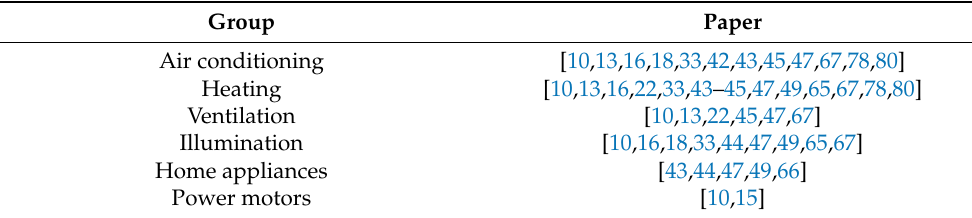
Table 2. Papers that reference factors that most influence the production of emissions.